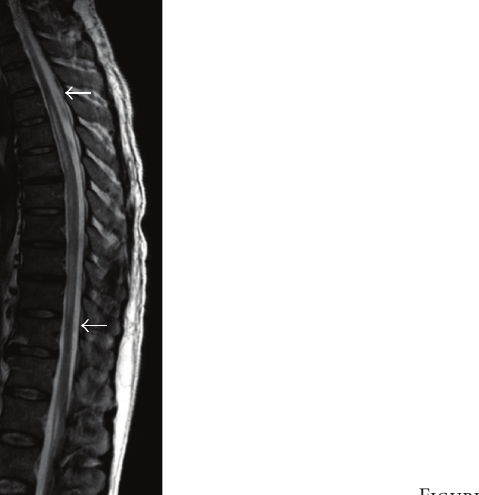
Figure 2: Axial T2-weighted brain MRI shows a large left-sided hyperintense occipital lesion.